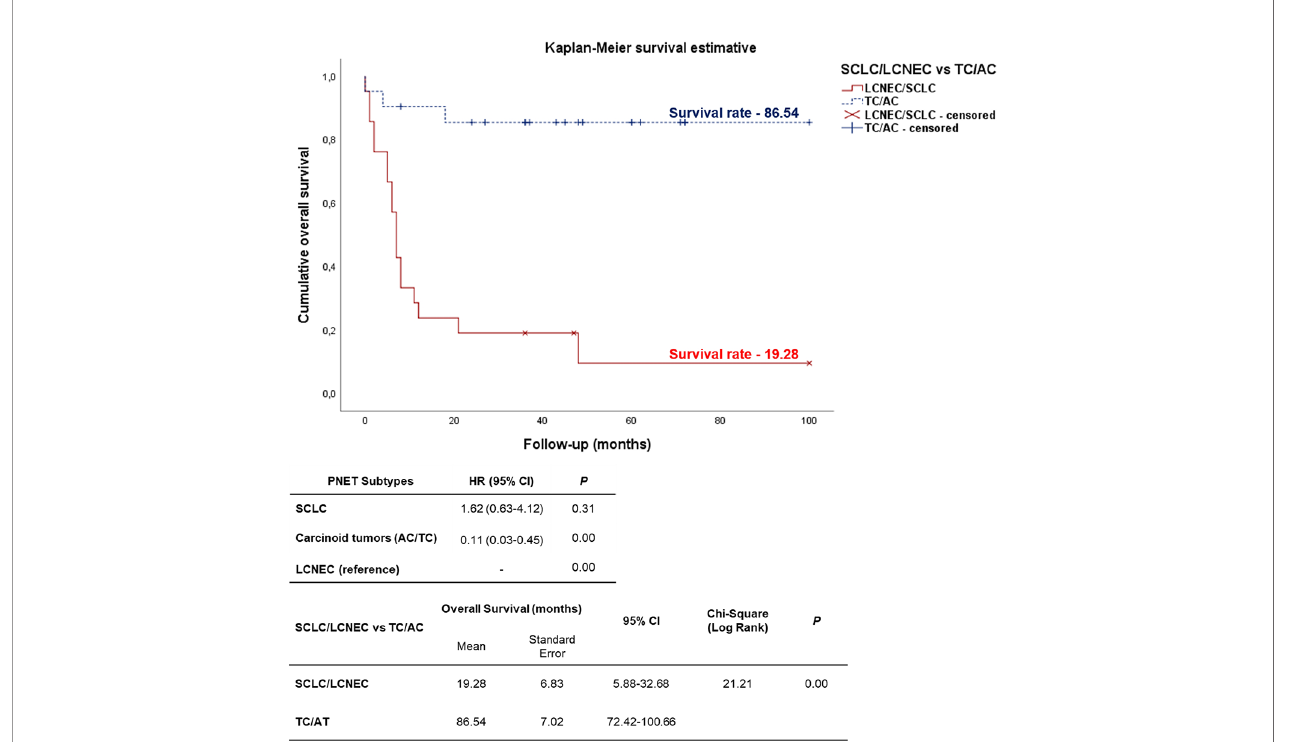
FIGURE 6 | Kaplan-Meier curve according to the PNENs histological subtypes. Patients diagnosed with carcinoid tumors (TC/AC) appears as top curve (median survival 86.54 months), while those who were diagnosed with high-grade neuroendocrine tumors (SCLC and LCNEC) (bottom curve) had median survival time of 19.28 months (P<0.01 by log-rank